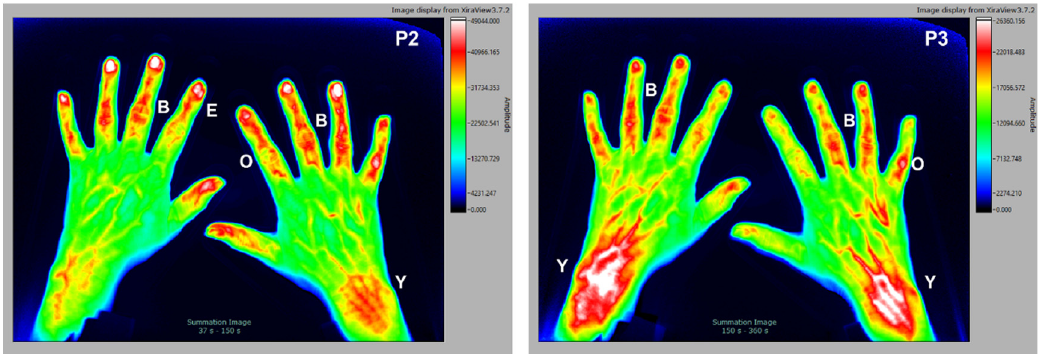
Figure 3. The 55 y/o female patient with clinical diagnosis of osteoarthritis. Signal enhancement seen around the joint capsules (O), in the connective tissue of the entheses (E) and tendons (B) of the fingers with a maximum in P2. Signal enhancement of the muscle–tendon junctions (Y) is visible in P3.